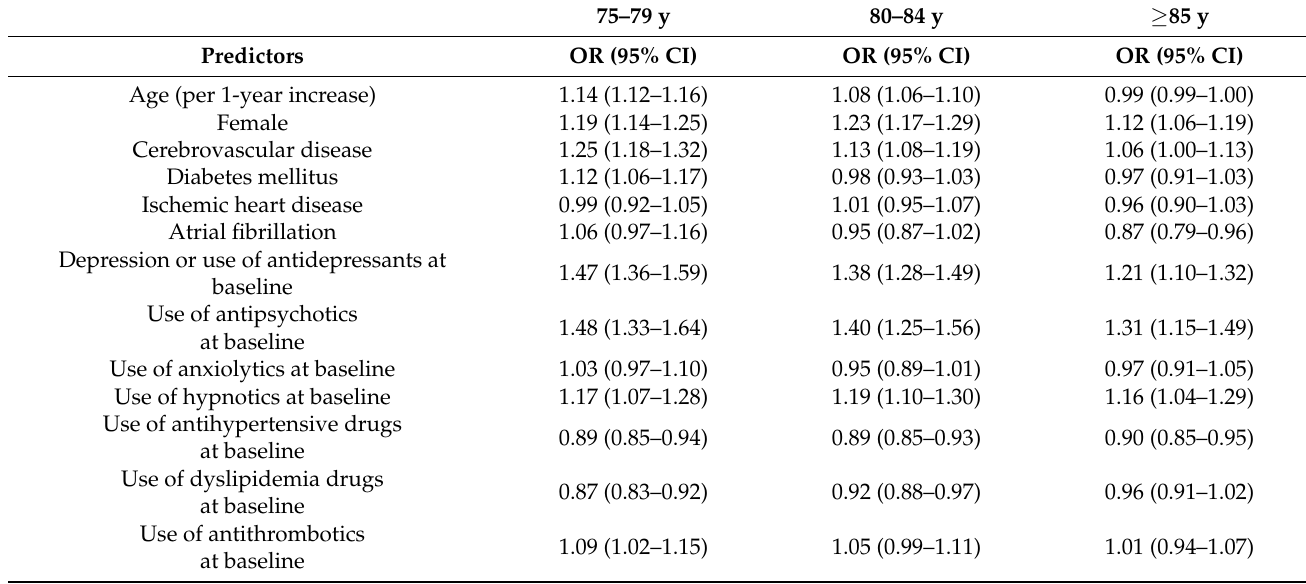
Table 4. Multivariable logistic regression analysis of predictors for new diagnosis of dementia by age